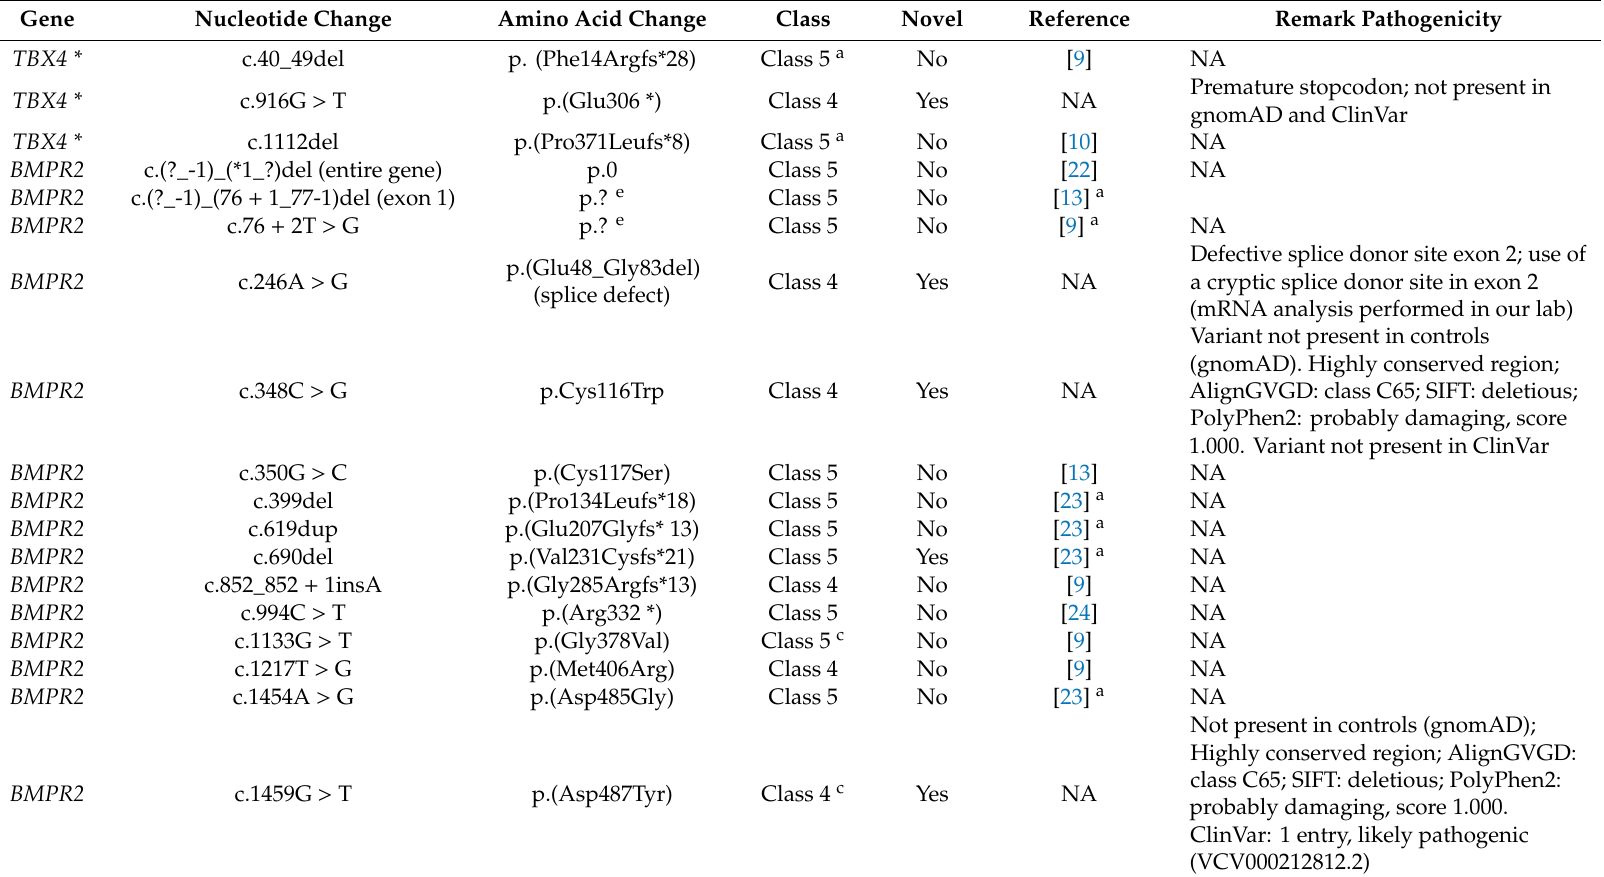
Table 2. Overview of the detected class 4 and 5 variants in 32 unrelated pulmonary arterial hypertension (PAH)